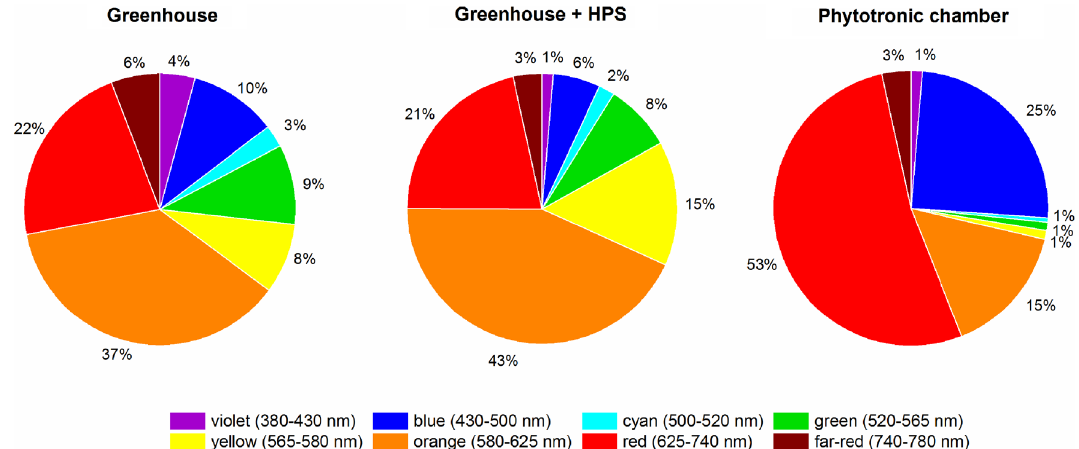
Figure 3. The percentage share of individual colours in the tested spectra. Greenhouse—solar radiation; Greenhouse + HPS—solar radiation supplemented with HPS lamps (High-Pressure Sodium); Phytotronic chamber—solo LED lamps (Light-Emitting diodes). Plants were grown in a greenhouse in the daylight (under 16-h photoperiod) supplemented with HPS lamps’ spectrum from 6.00 to 10.00 a.m., and in a phytotronic chamber with only LED spectrum. Greenhouse and Greenhouse + HPS were presented to demonstrate the influence of HPS spectrum on daylight.